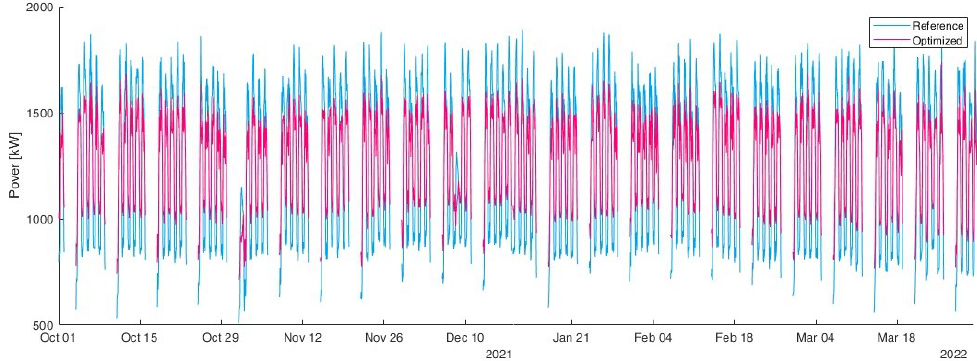
Figure 17. Comparison between the reference unoptimised load (in blue) with the optimised one considering labour cost (in purple).